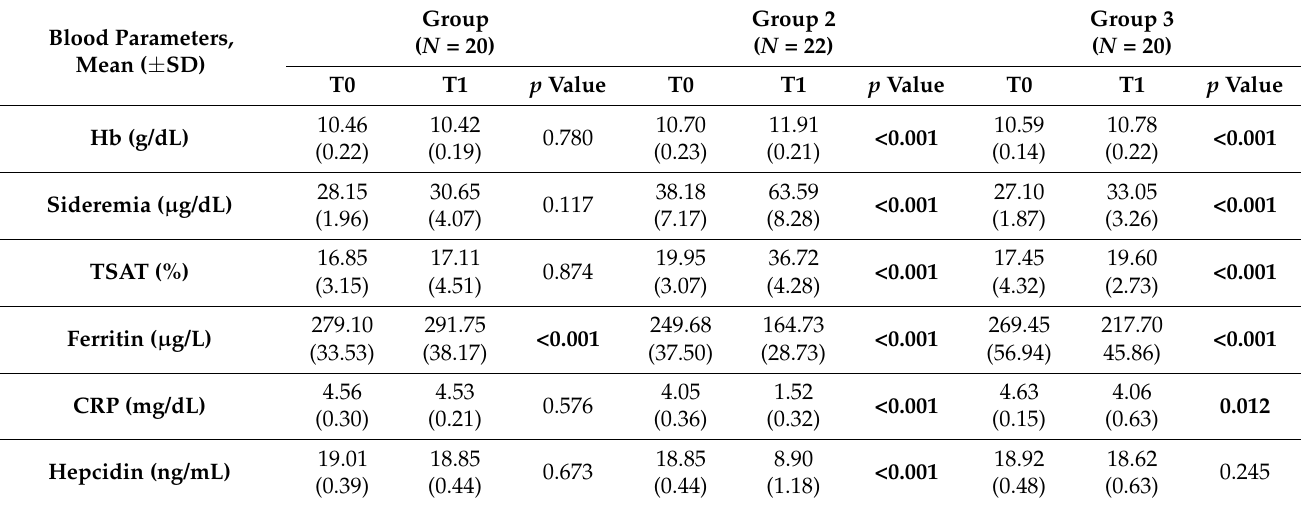
Table 2. Blood parameters of patients treated with ferrous sulfate (Group 1); ferric sodium EDTA in combination with vitamin C, folic acid, copper gluconate, zinc gluconate, and selenomethionine (Group 2); or ferric liposomal formulation (Group